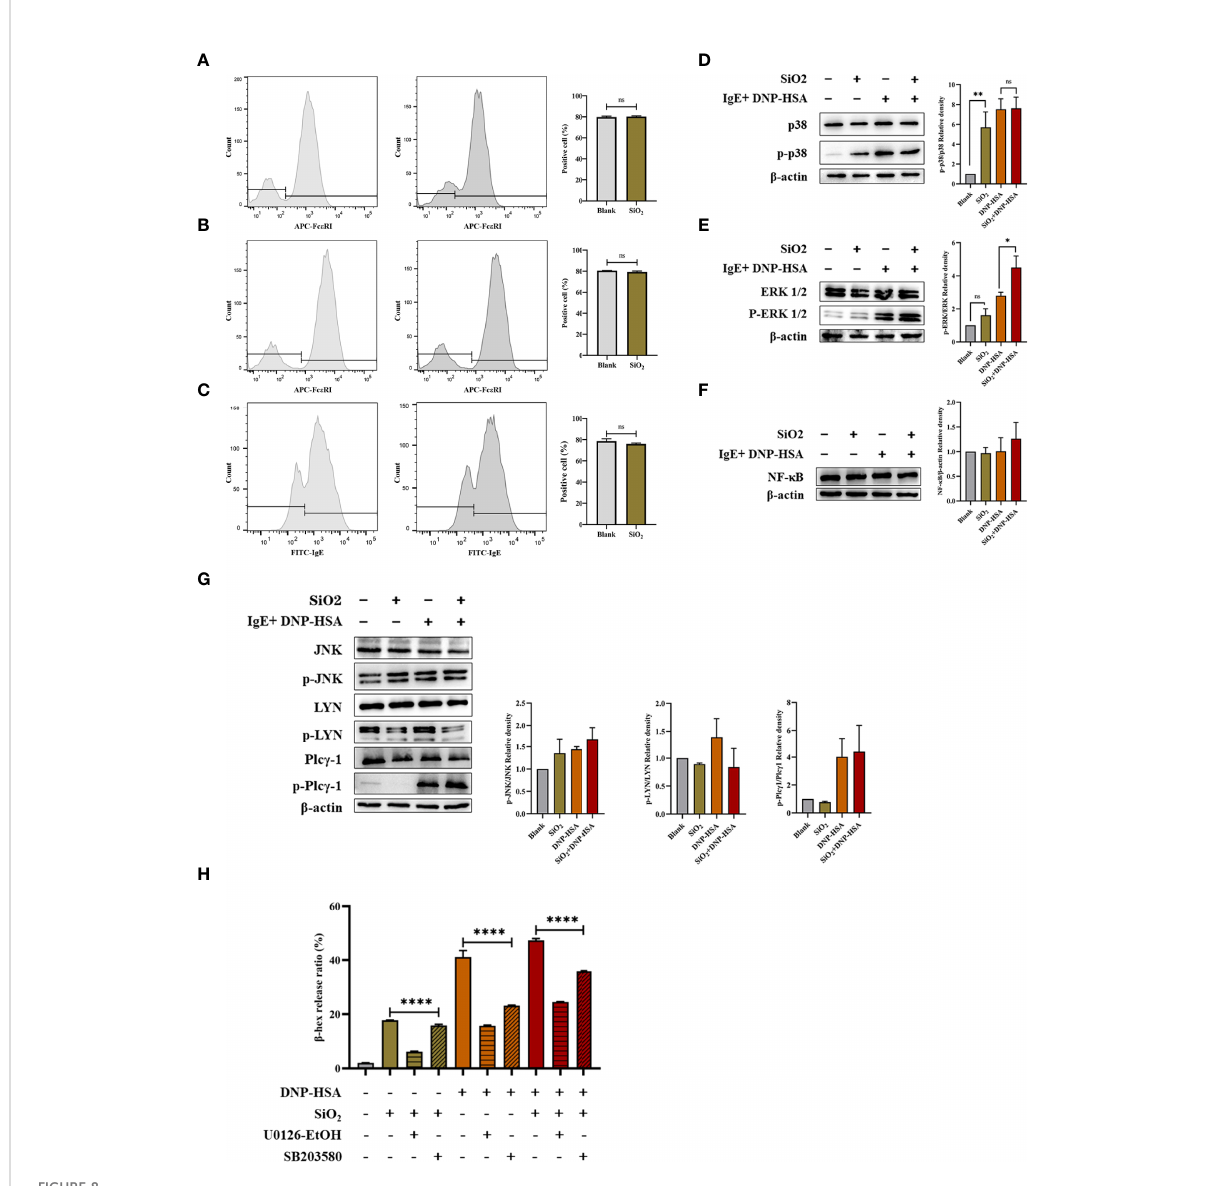
FIGURE 8 Fc ϵ RI-mediated signaling in mast cells. (A) BMMCs were not sensitized with anti-DNP IgE and treated with nano-SiO 2 . The results showed no signi fi cant difference in Fc ϵ RI expression compared to the blank control. (B, C) BMMCs were sensitized with anti-DNP IgE and washed to remove unbound anti-DNP IgE before treatment with nano-SiO 2 . There were no signi fi cant differences in Fc ϵ RI expression (B) or IgE binding capacity (C) compared to the blank control. (D – G) BMMCs were sensitized with anti-DNP-IgE, treated with nano-SiO 2, and stimulated with DNP-HSA. The cell lysates were analyzed by Western blotting with different antibodies against the NF- k B proteins and the phosphorylated and nonphosphorylated forms of the p38, ERK1/2, JNK, LYN, and Plc g 1 proteins. Relative density bars represent the means ± SD. (H) b - hexosaminidase release ratio from activated BMMCs pretreated with signaling inhibitors (ERK inhibitor U0126-EtOH 5 m M/L and p38 inhibitor SB203580 10 m M/L). The unpaired t test or ordinary one-way ANOVA was used to compare different groups. * P < 0.05, ** P < 0.01, **** P < 0.0001. ns, no signi fi